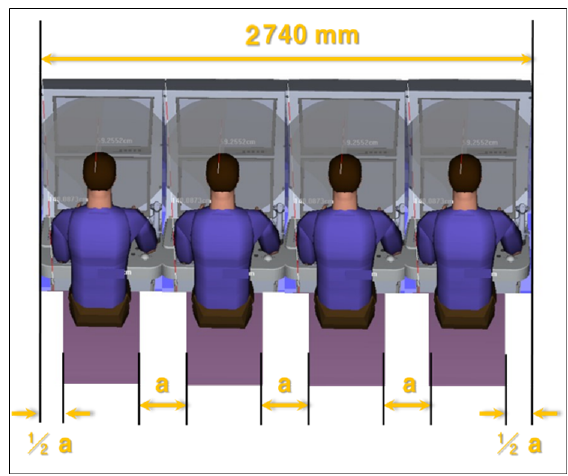
Figure 4. Deployment status of four submarine naval multi-function consoles.